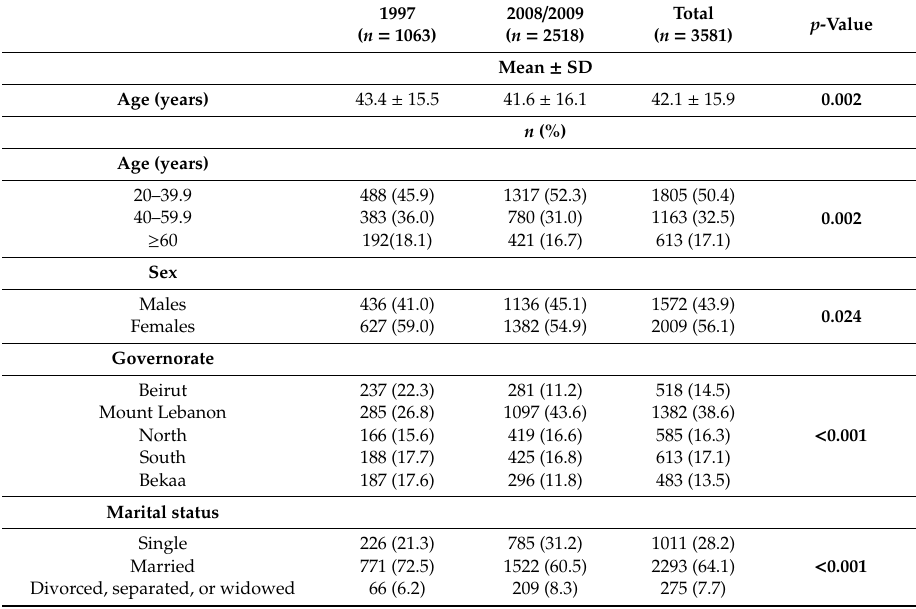
Table 1. Sociodemographic characteristics of the total study population ( n = 3581) by survey year, Lebanon, 1997 ( n = 1063) and 2008 / 2009 ( n =